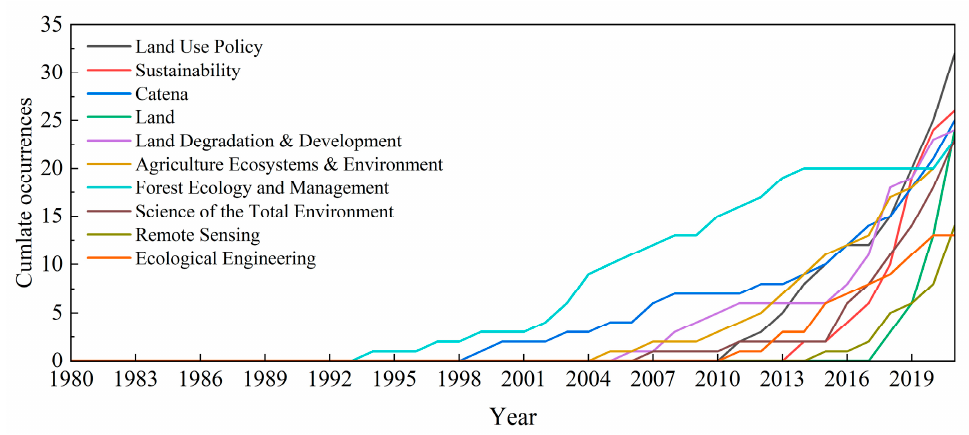
Figure 4. Growth curves of journal sources on farmland abandonment from 1980 to 2021.